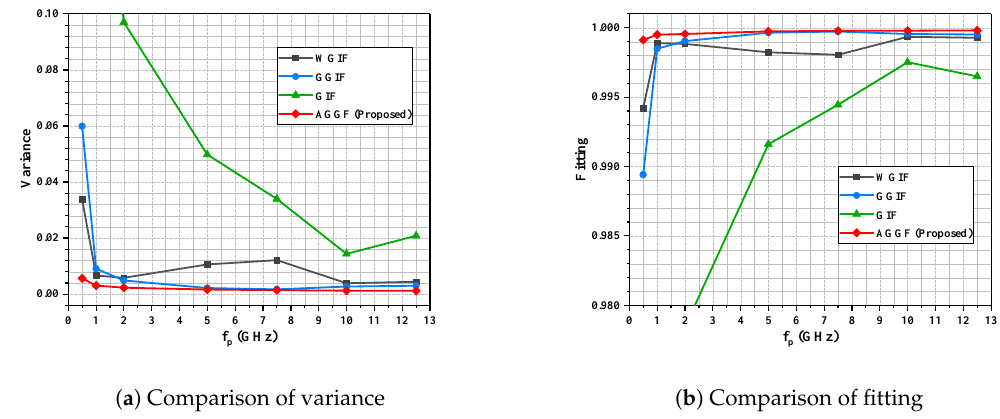
Figure 12. Seabed experiment, SNR = 30; influence of f p on filtering